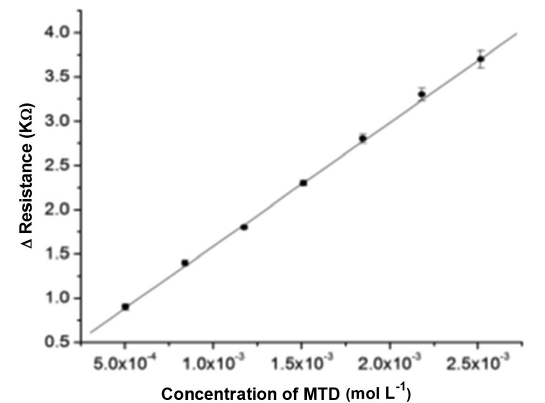
FIGURE 5 - Analytical curve for determination of